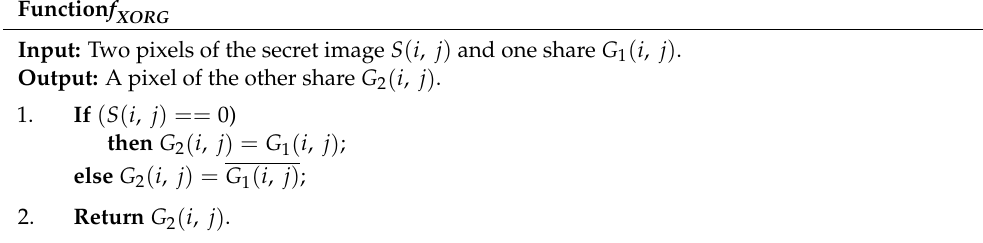
Algorithm 1, shown below (for Algorithm I), has the goal of simultaneously encrypting multiple secret images into two shares. The purpose is to shift one of the shares by i unit and superimpose it back into another share to restore i th secret image. Before starting Algorithm 1, we need to number the N secret images S 0 , S 1 , S 2 , . . . , S N –2 , S N –1 . Then, we assign two consecutive secret images as pairs ( S 0 , S 1 ), ( S 1 , S 2 ), . . . , ( S N –2 , S N –1 ), ( S N –1 , S 0 ). In a secret image of size w × h , the secret image is split into p parts, which means that each shift is in units of ( w / p ) pixels. In addition, the value of p must be mutually prime with N –1; otherwise, when generating the share, the value of the same position will be repeatedly generated in the loop, causing the stacked share to be unsuccessful in recovering the secret image. We randomly chose any two consecutive secret images ( S A , S A + 1 ) to encrypt each pixel. Since when A = N –1, the last secret image, the next must be the first secret image, 0. The formula for the variables will be different in this case than in the other cases, so Step 5 must be separately presented. The schematic diagram of Algorithm 1 is shown in Figure 3.